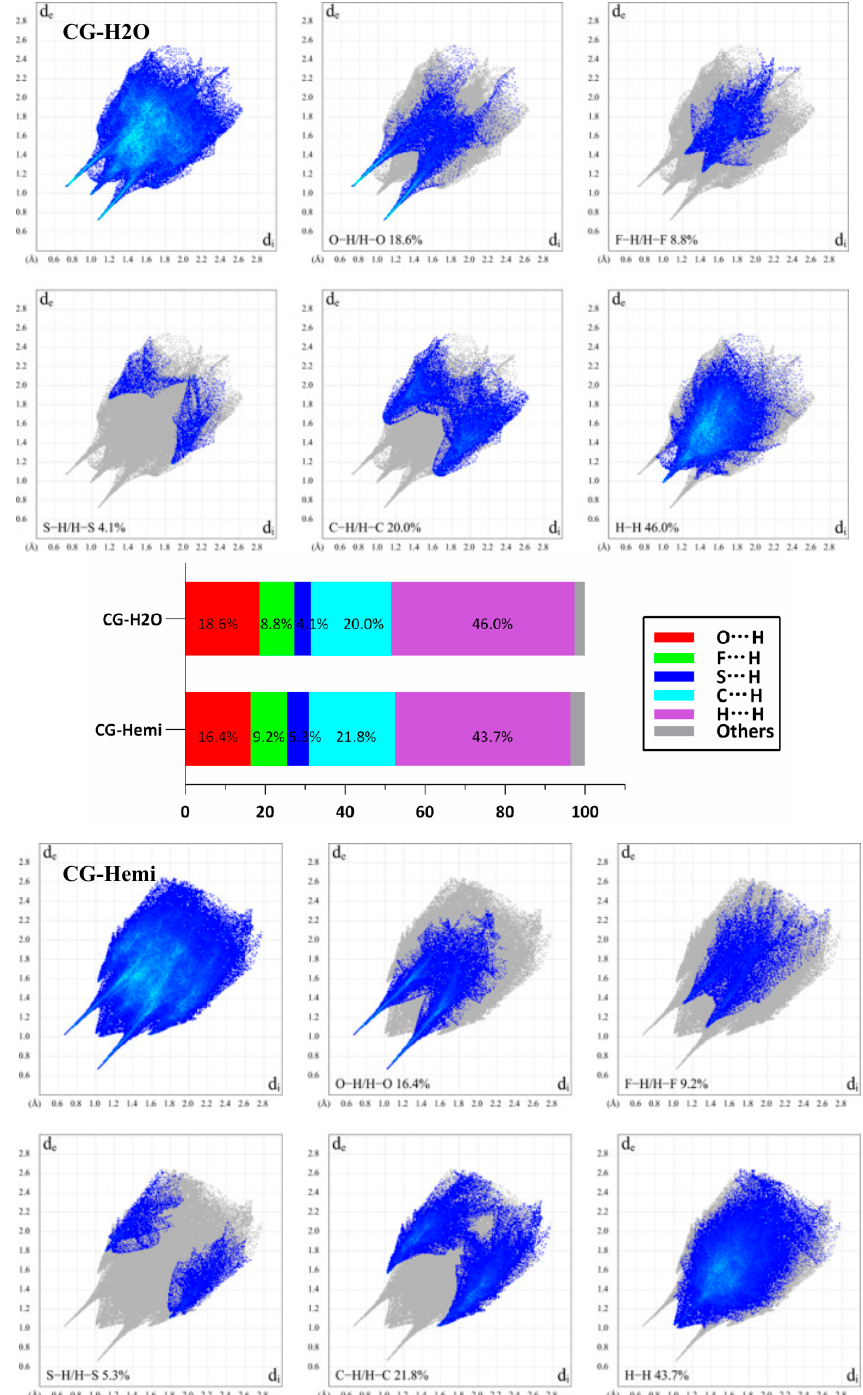
Figure 6. 2D fingerprint plots of the Hirshfeld surfaces for CG-H 2 O (upper) and CG-Hemi (lower). The relative percentage contributions to the Hirshfeld surface area of various intermolecular contacts for CG-H 2 O and CG-Hemi (middle). d e is the distance from the point to the nearest nucleus external to the surface, and d i is the distance to the nearest nucleus internal to the surface. In order to study, the packing of the crystal structure and the supramolecular rearrangement of CG-H 2 O and CG-Hemi, total energy framework diagrams of CG-H 2 O and CG-Hemi were shown in Figure 7 along a-axis. Total energy included four